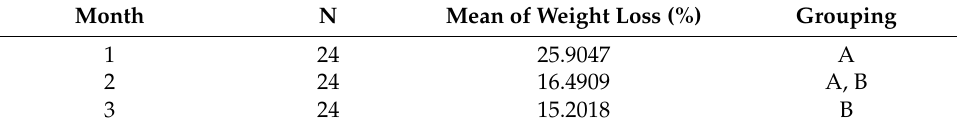
Table 7. Grouping information of period of time using the Tukey method and 95% confidence.